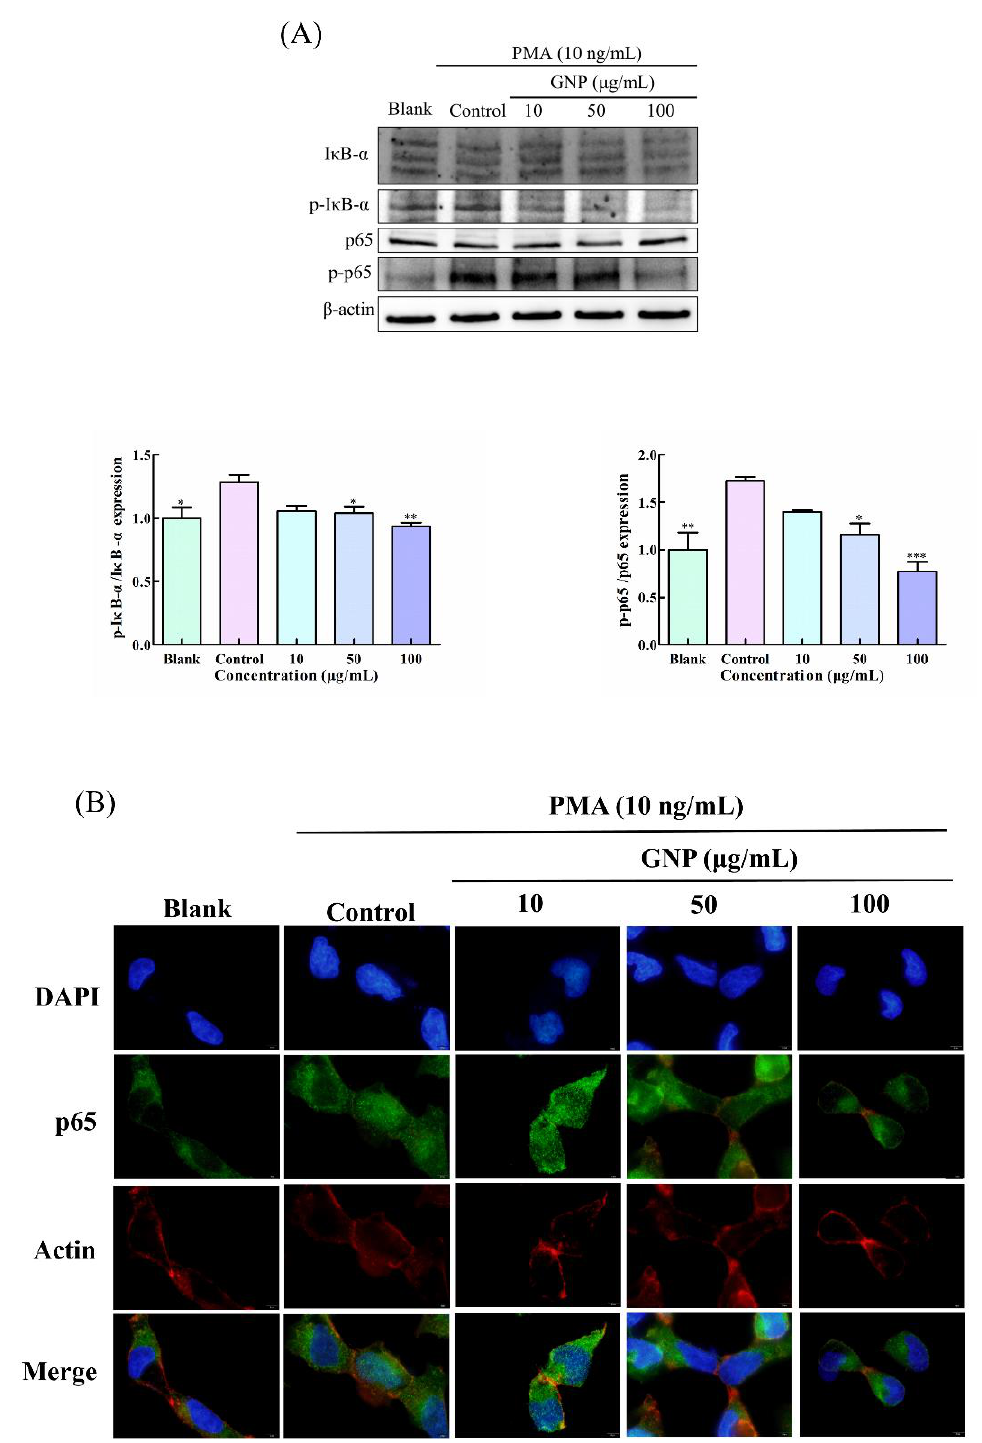
Figure 5. ( A ) The protein expression level of NF- κ B signaling pathway in HT1080 cells. β -actin was used as an internal control. ( B ) Nuclear translocation of p65 was observed through an overlay of green p65 staining with blue DAPI staining and red cytoskeleton staining. Data are shown as mean ± SD ( n = 3). p < 0.05 (*), p < 0.01 (**), p < 0.001 (***) compared with PMA alone treated control group.